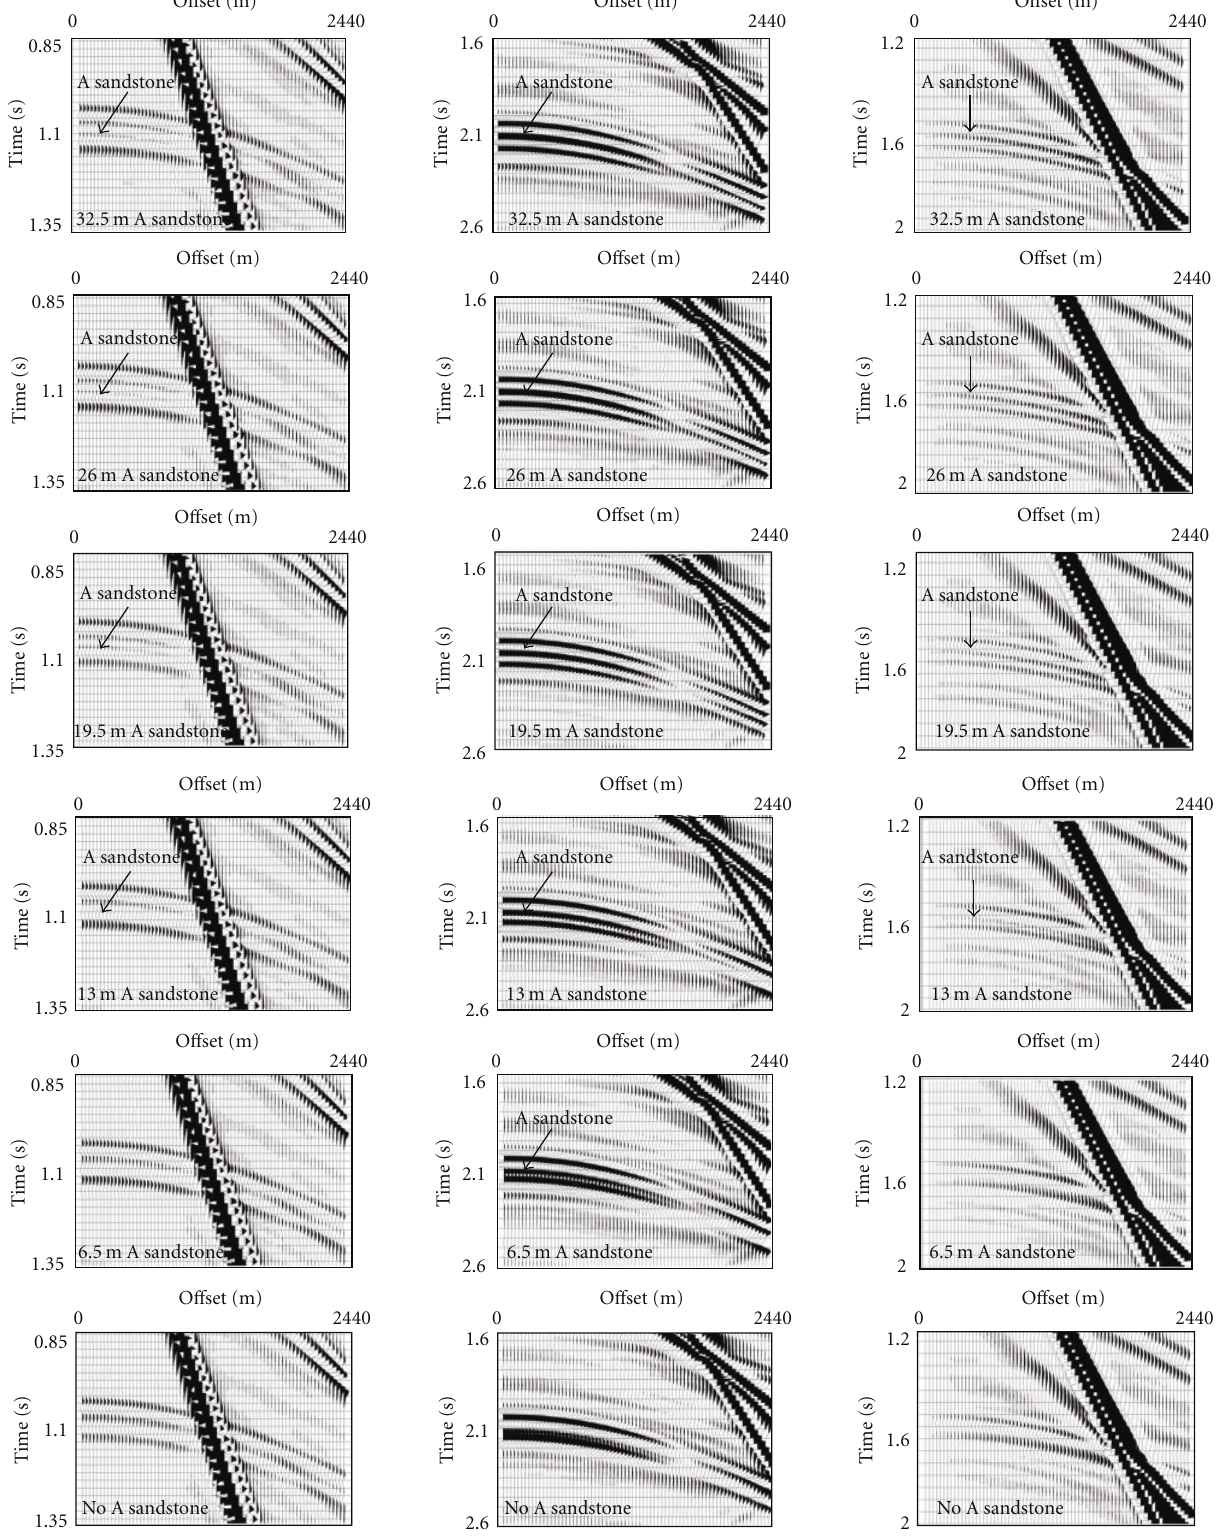
Figure 15: P-wave gathers (left), S-wave gathers (center) and PS-wave gathers (right) generated using Models 3a, with changing A sandstone thickness from 0 to 32.5m. The synthetic gathers show that it is di ffi cult to detect less than 13m sandstone thickness using P-waves, since the peak doublet is absent. In PS-wave gather, the separate peak response is not present for 13m of A sandstone thickness. The S-wave gather shows a distinct peak response even for 6.5m of A sandstone